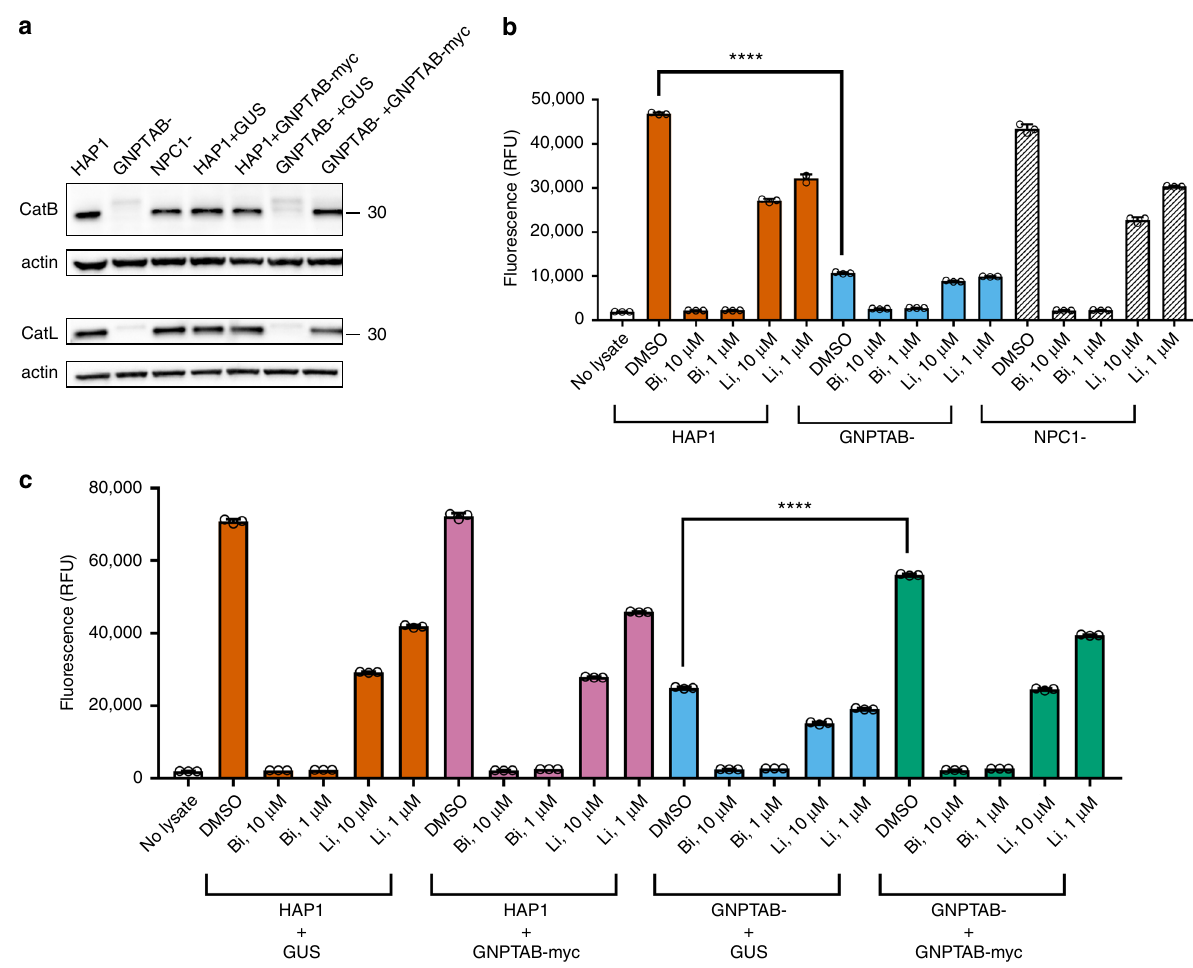
Fig. 5 Cathepsins are reduced in GNPTAB - knockout cells, but restored upon GNPTAB reconstitution. a Immunoblotting of lysates from parental, knockout and reconstituted cells for CatB and CatL. The migration of a 30 kDa molecular mass marker is shown to the right. b CatB activity in lysates from parental HAP1, or knockout GNPTAB- or NPC1-cells. Cells were treated with cathepsin B inhibitor (Bi), cathepsin L inhibitor (Li), at 10 or 1 µ M, or DMSO vehicle control for 1 h at 37 °C, before lysis and incubation with fl uorescent CatB peptide substrate. After 1 h incubation at room temperature, fl uorescence was measured. Data represent the mean ± s.d. of three technical replicates. A representative of three independent experiments is shown. c CatB activity in lysates from reconstituted cells. Lysates from transduced HAP1 or GNPTAB − cells were generated and tested for CatB activity, as for panel b . Data represent the mean ± s.d. of three technical replicates. A representative of two independent experiments is shown. For both panels b and c , statistical analysis was performed with a two-tailed Student ’ s t -test with signi fi cance shown as **** P ≤